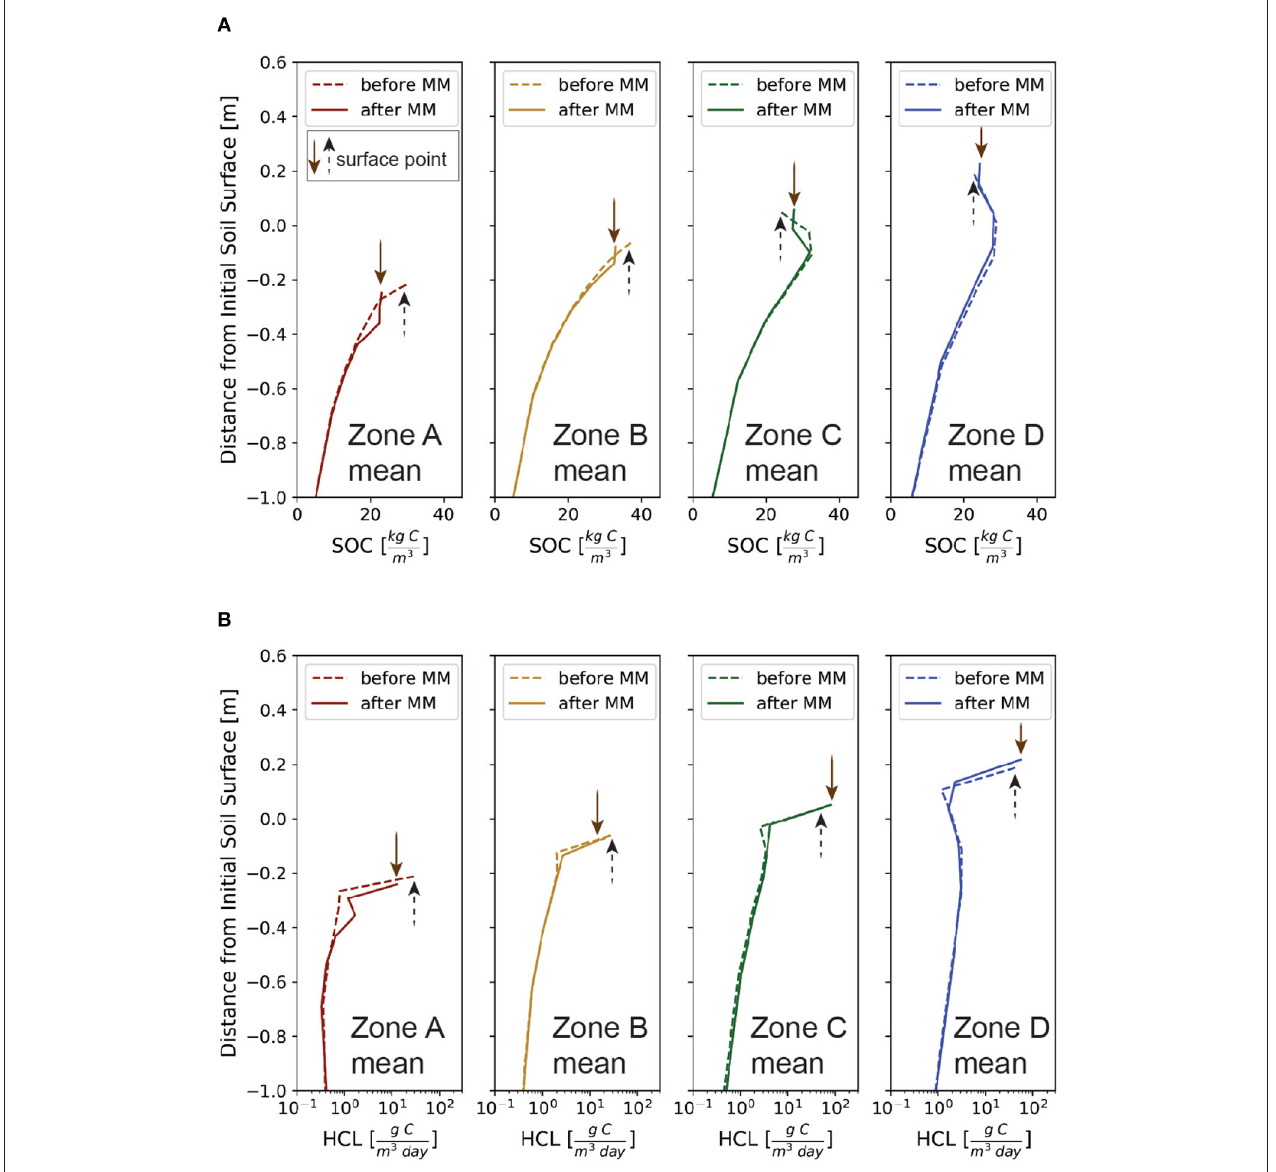
FIGURE 7 | Comparison of (A) SOC and (B) HCL profiles for before and after the mechanical mixing (labeled MM in the figures) for the 4 zones ( Figure 2a ). The profiles are for spatially averaged daily mean for years 85 and 140 to capture the scenarios before and after mechanical mixing,